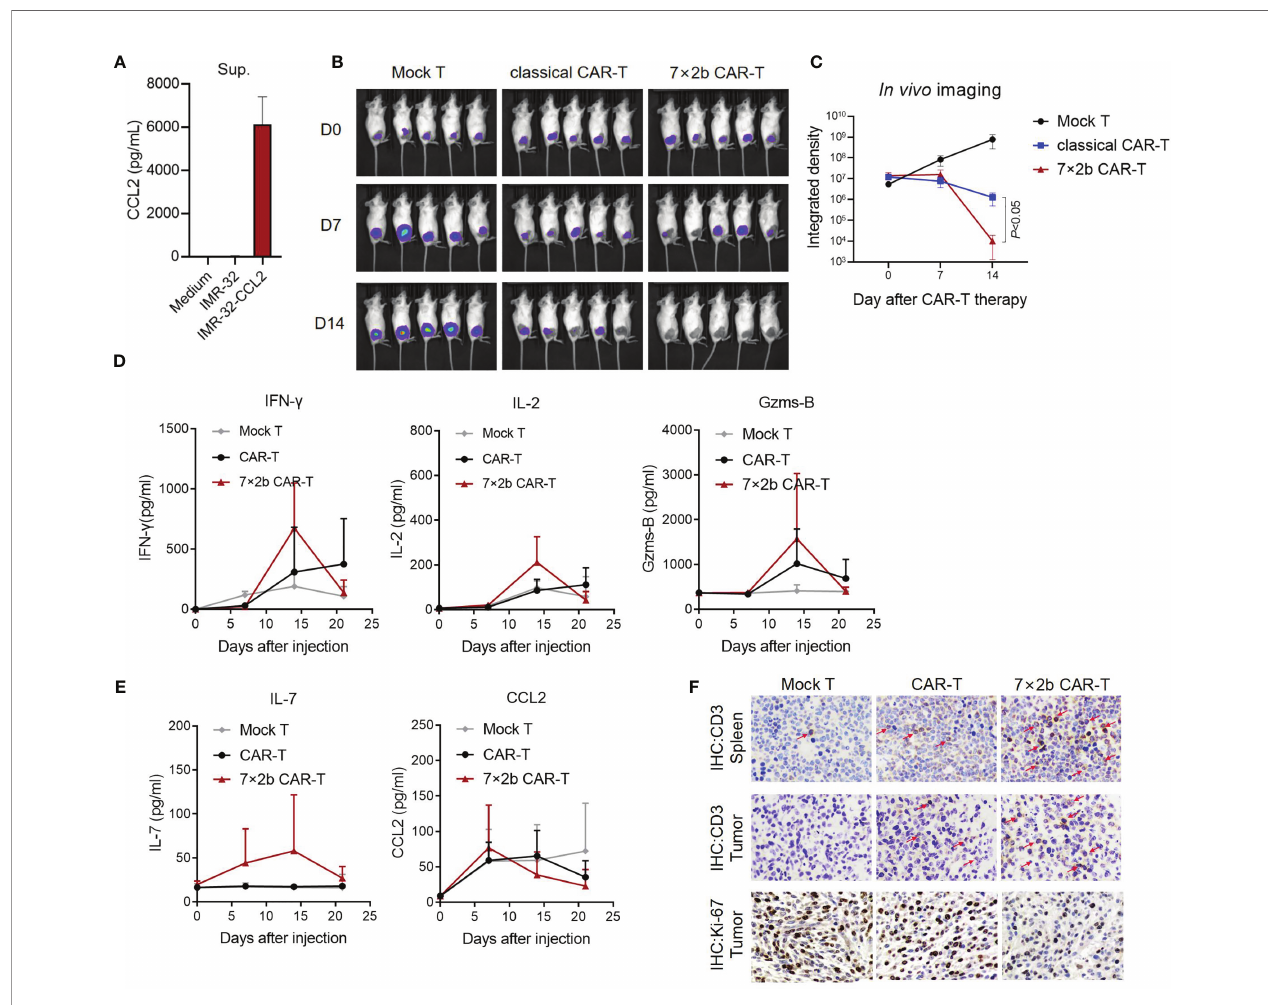
FIGURE 4 | Anti-tumor activity of the 7×2b CAR-T cells in vivo . (A) The level of CCL2 secretion in IMR-32-CCL2 cells was detected by ELISA. (B) The antitumor activity of CAR-T cells was evaluated by in vivo imaging in mice bearing IMR-32-CCL2 xenografts. (C) Fluorescence evaluation of the in vivo imaging of the mice in (B) . (D) The levels of IFN- g , IL-2, and GZMS-B in the sera of the mice were detected by ELISA. (E) IL-7 and CCL2 were also measured. (F) The human CD3 and Ki-67 positive cells in the spleen and tumor of the mice were detected by immunohistochemistry after CAR-T infusion. N =